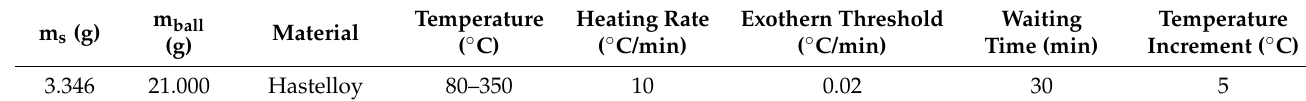
Table 3. ARC test parameters for LP30 + PFPN.